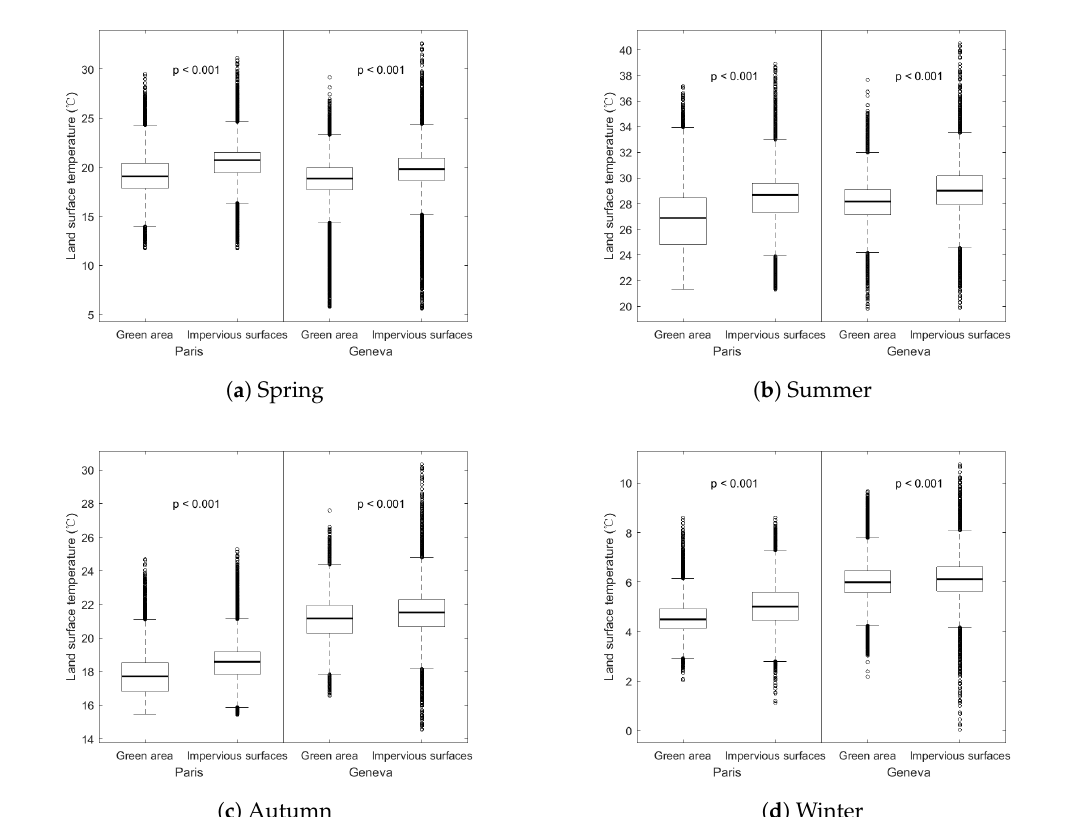
Figure 8. Box charts related to land surface temperature of green area and impervious surfaces for four seasons observed in Paris and Geneva.